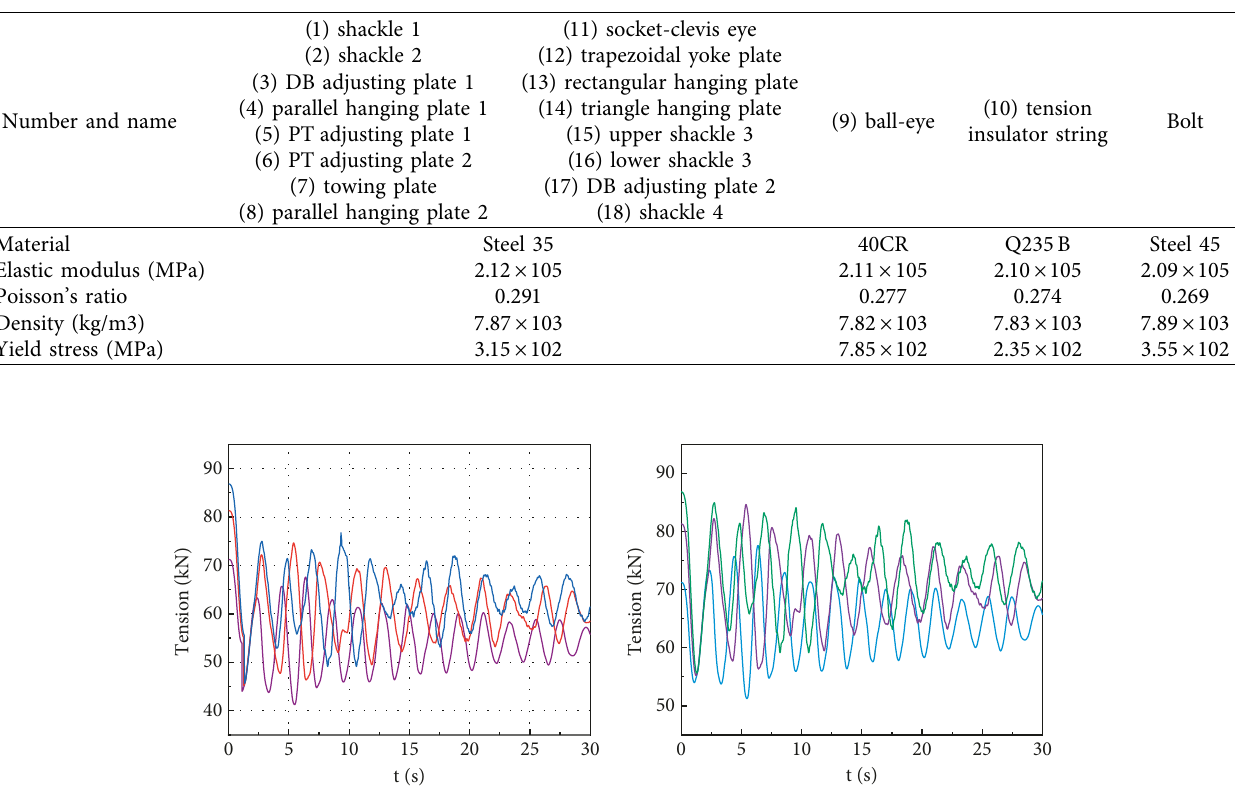
Table 8: Material parameters of tension string parts.